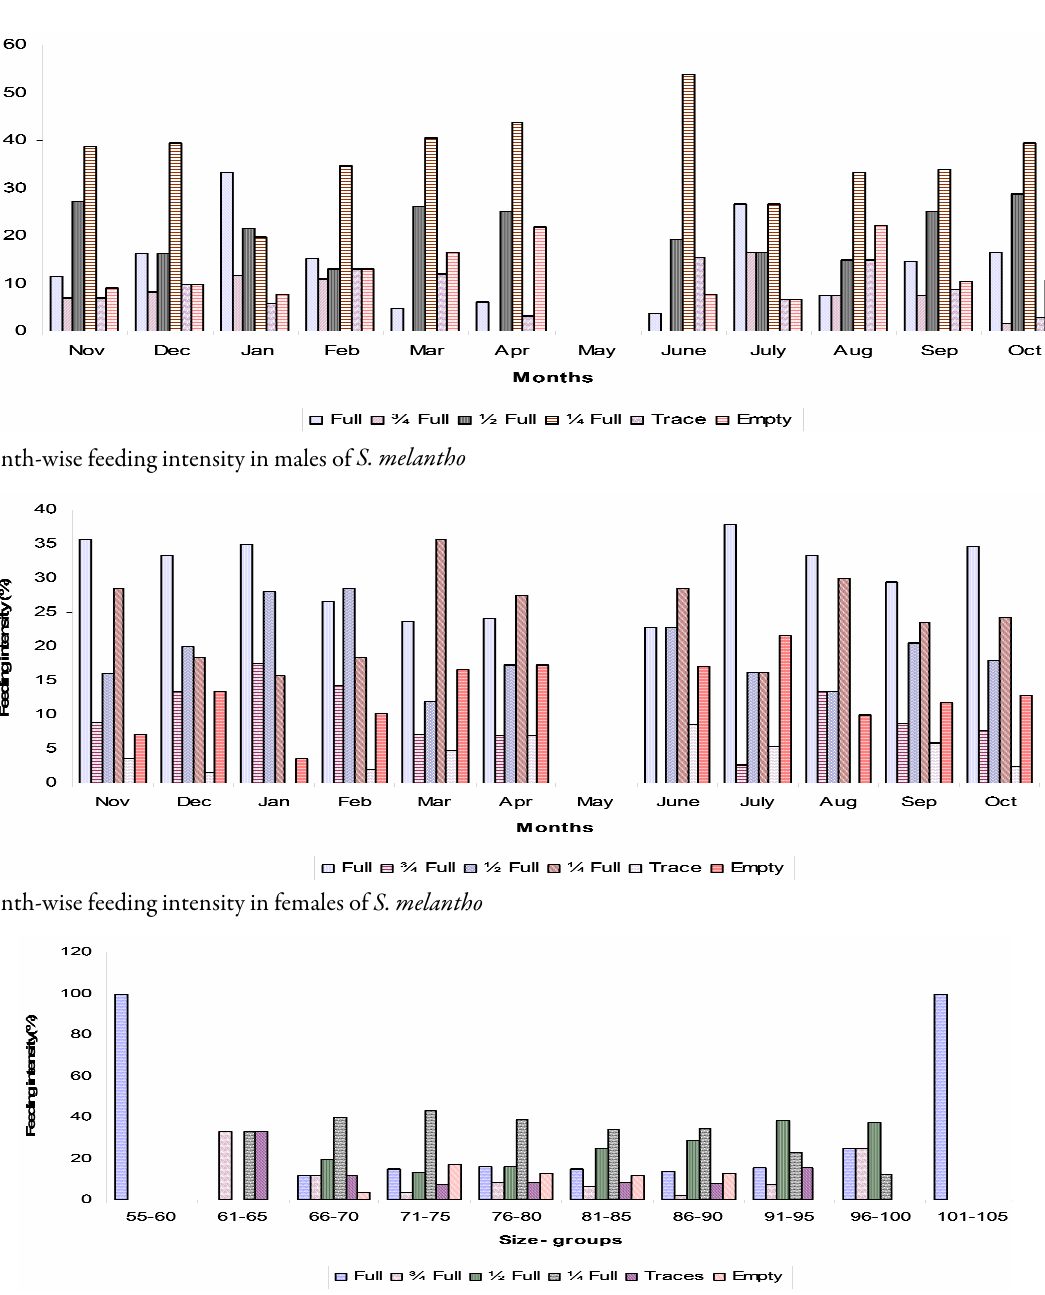
Fig. 10. Feeding intensity in different size-groups of males of S.